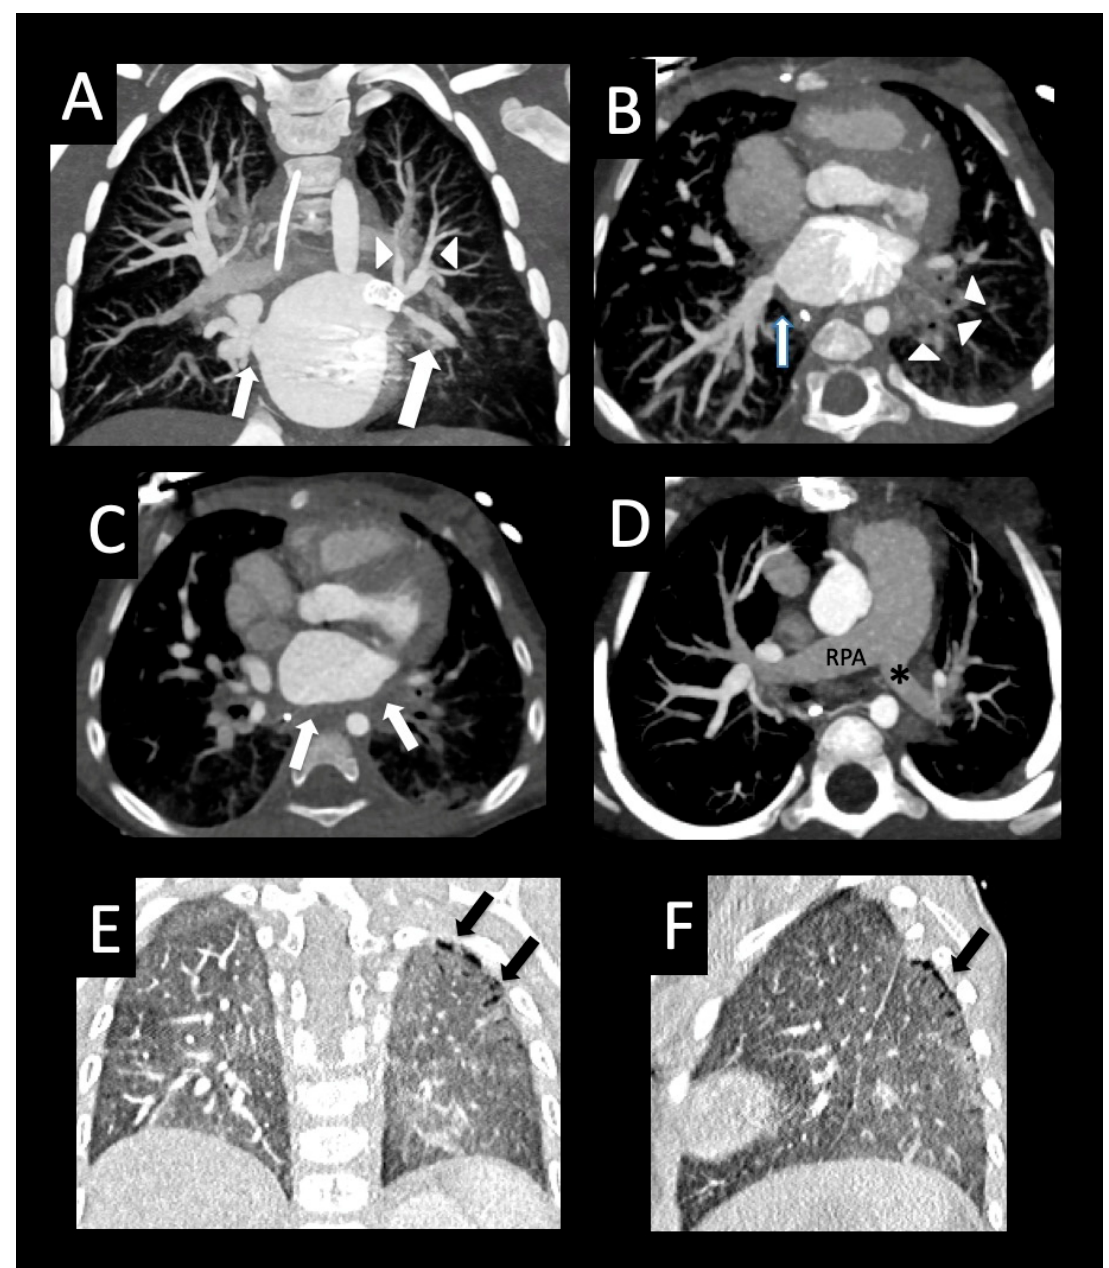
Figure 12. Pulmonary vein stenosis after repair of congenital heart disease. Full-term infant who developed severe bilateral pulmonary vein stenosis after surgical repair of subaortic stenosis, coarctation of the aorta, and ventricular septal defect. The right common pulmonary vein ostium was resected, and the left common confluence was anastomosed to the left atrial appendage with subsequent recurrent left pulmonary vein stenosis and stenting of the left upper pulmonary vein. Follow-up CT shows the left upper pulmonary vein stent (coronal image, ( A )) extending to the lingular vein (large arrow) that crosses and “jails” the left upper pulmonary vein branches (arrowheads), and mild right upper pulmonary vein ostial stenosis (small arrow, ( A )). Axial image ( B ) shows moderate stenosis of the right lower pulmonary vein ostium (arrow) and left-sided perihilar induration (arrowheads). The left lower pulmonary vein could not be visualized, consistent with atresia. Axial image ( C ) shows diffuse wall thickening of the posterior left atrium (arrows). The right pulmonary artery (RPA) is dilated relative to the left pulmonary artery (*) (axial image, ( D )). Coronal ( E ) and sagittal ( F ) images show diffuse decreased vascularity of the left lung relative to the right, and peripheral cysts within the superior segment of the left lower lobe (arrows).